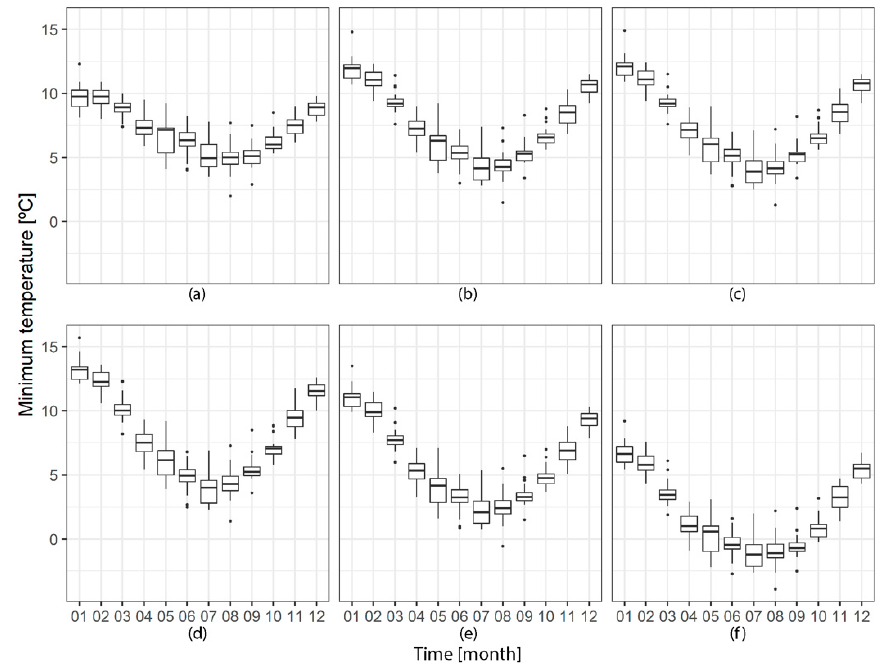
Figure A3. Box-plot of minimum temperature per month for the agro-climatics areas of Biobio: ( a ) Secano Costero, ( b ) Secano interior, ( c ) Depresión Intermedia, ( d ) Cordón Isla, ( e ) Precordillera and ( f ) Cordillera.